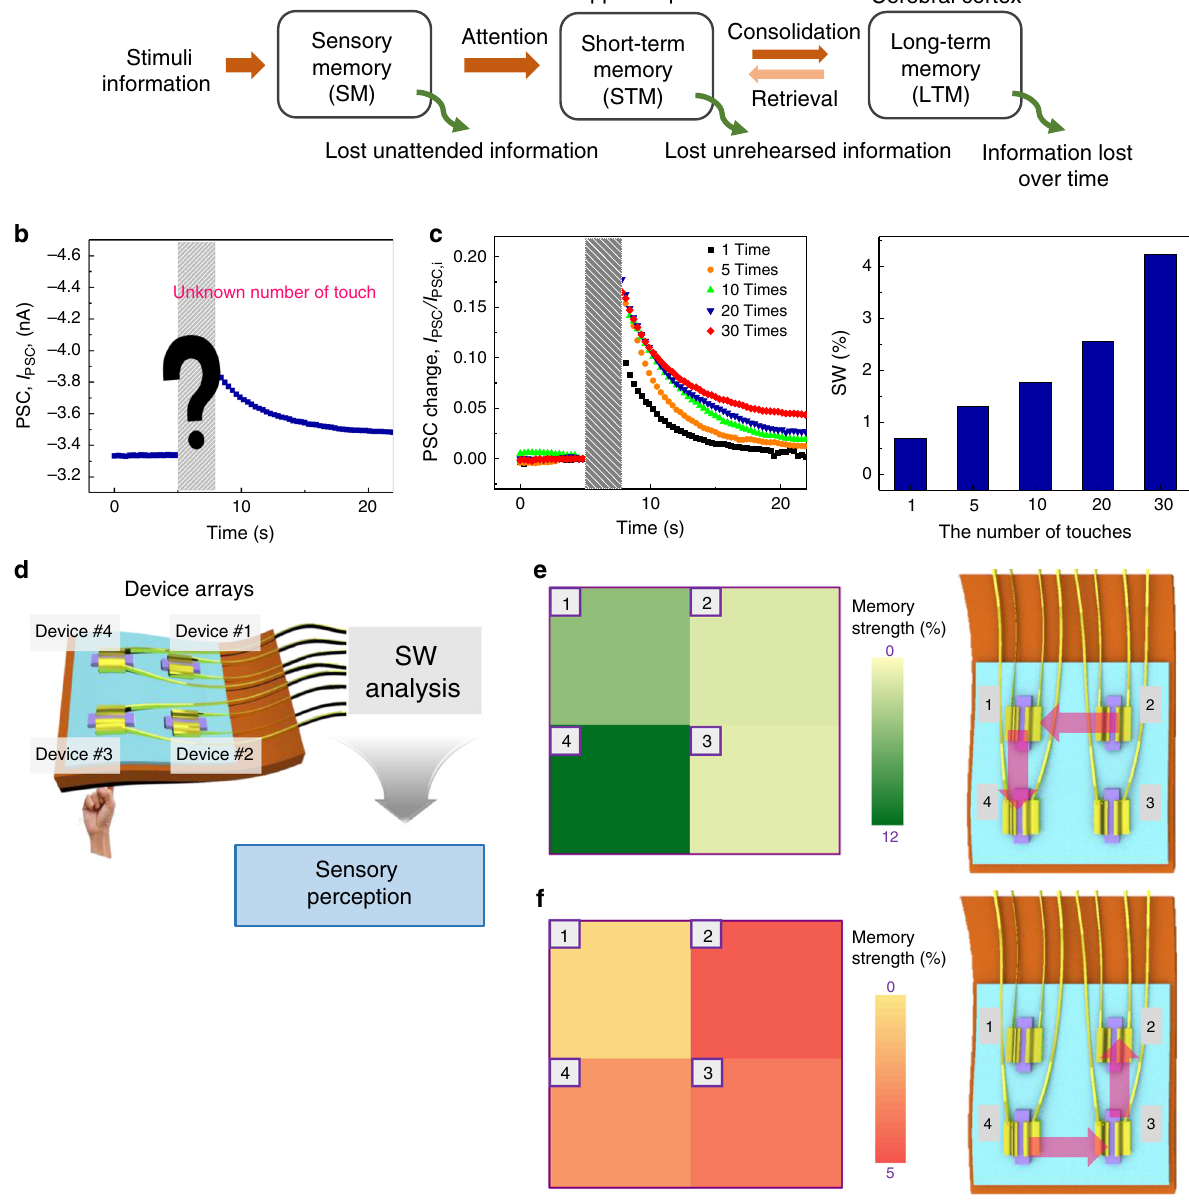
Fig. 4 Intelligence of an AiS-TSO with sensory memory. a A typical model of learning and memory processing in human neural systems illustrating sensory-memory, short-term memory, and long-term memory behaviors. b The PSC of the AiS-TSO in response to tactile stimulation with an unknown number of stimuli. c Relative PSC change ratio ( Δ I PSC / I PSC,i ) according to number of touches (frequency, 1 Hz and pressure, ≈ 1 kPa of touch) (left). The real-time PSC during the stimulation was obscured. SW of the AiS-TSO according to number of touches right). d Schematic illustrations of the AiS-TSO showing reception and preprocessing in parallel and the intelligence, including sensory memory, afforded by analysis of SW. e , f Schematic illustration of mapping of the memory magnitude of pixels in a 2 × 2 array of AiS-TSOs and the expected order (2 → 1 → 4 → for e , 4 → 3 → 2 for f ) of touched pixels based on memory magnitude, which is related to